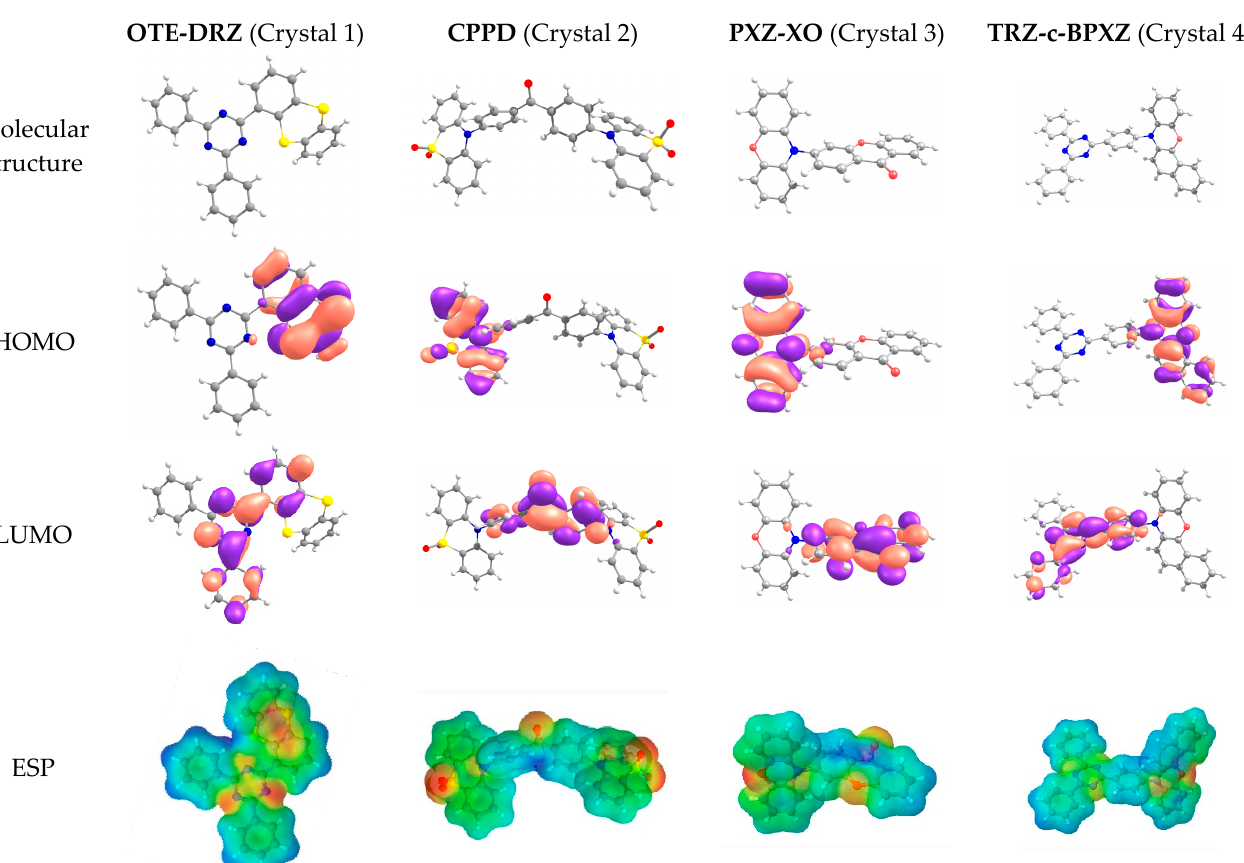
Figure 1. Molecular structures, HOMO and LUMO patterns, and ESP distributions for the compounds studied.